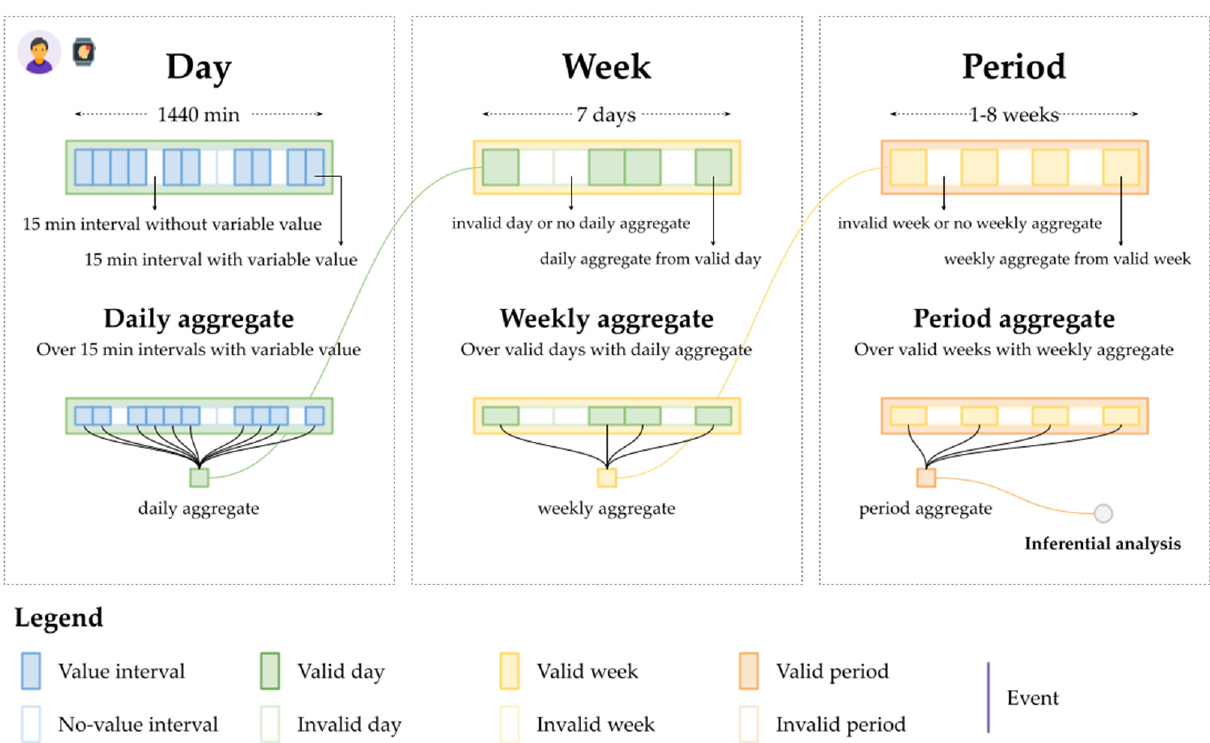
Figure 2. Data aggregations over valid days, valid weeks, and valid periods. A day (depicted in green in the top left ) contains 96 15-min intervals (depicted in blue; the intervals with a value are solid blue, while those without a value are pale blue). A daily aggregate (in green in the bottom left ) is constructed from the 15-min intervals with values. A week (depicted in yellow in the top center ) contains seven days (in green; the valid days are solid green, while those invalid are pale green). A weekly aggregate (depicted in yellow in the bottom center ) is constructed from the daily aggregates of the valid days. A period (in orange in the top right ) contains 1–8 weeks (depicted in yellow; the valid weeks are solid yellow, while those invalid are pale yellow). A period aggregate (depicted in orange in the bottom right ) is constructed from the weekly aggregates of the valid weeks. The period aggregate is then used for the inferential